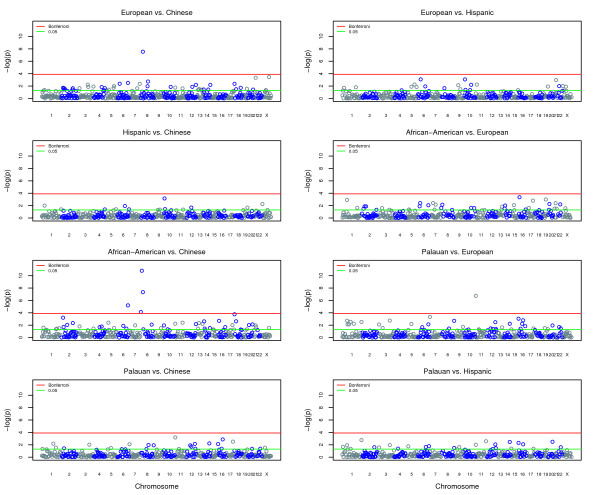
Population-specific comparisons of map interval lengths. The - log10(p-values) measuring map interval differences are plotted in chromosomal order, with chromosomes shown in alternating colors for clarity. The green line indicates the p = 0.05 significance threshold while the red line indicates the Bonferroni-corrected significance threshold.